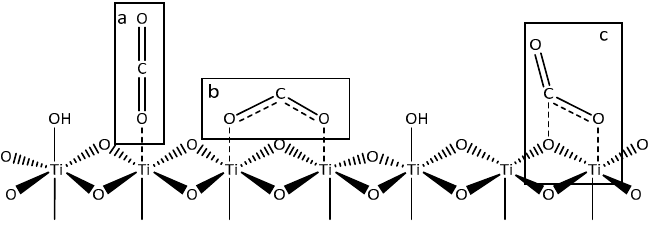
Figure 1 . Schematization of interaction between TiO 2 surface and CO 2 : linear ( a ), chelate like ( b ) and carbonate like ( c ).